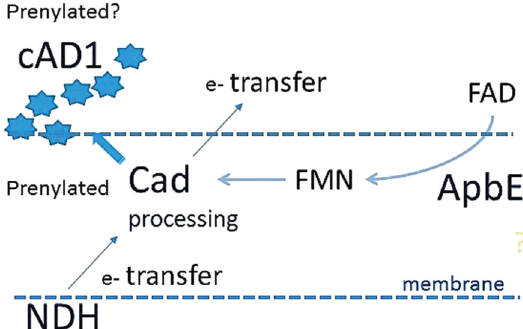
Figure 9: Suggested functional interaction between cAD1 pheromone and ApbE/FAD:protein FMN transferase. The release of cAD1 peptide pheromone may depend on a FMN-based electron transfer activity or a conformation of the lipoprotein precursor (Cad). ApbE works as a chaperone facilitating covalent binding of FMN and FAD/FMN extracellu- lar